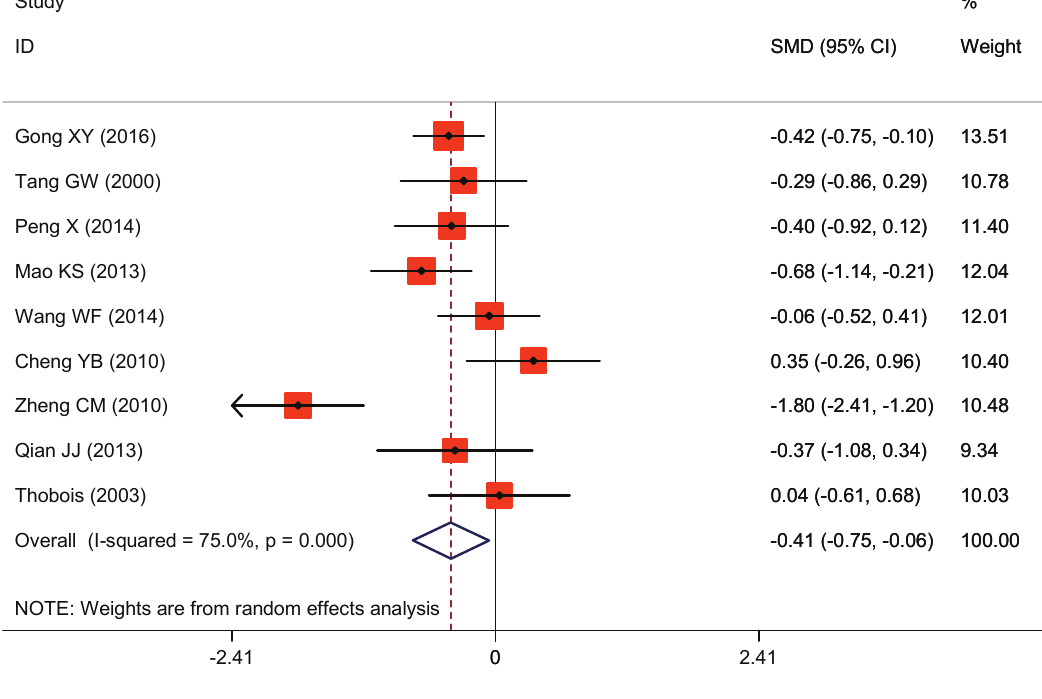
Figure 3: Forrest plot of UPDRS score changes for piribedil in adjuvant treatment of Parkinson’s Disease